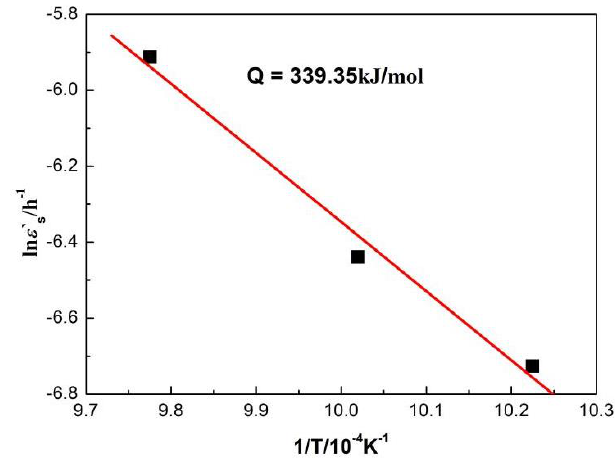
Figure 12. Relationship of the lg s - lgσ a of IFed alloy at 705 °C/690 – 897 MPa.